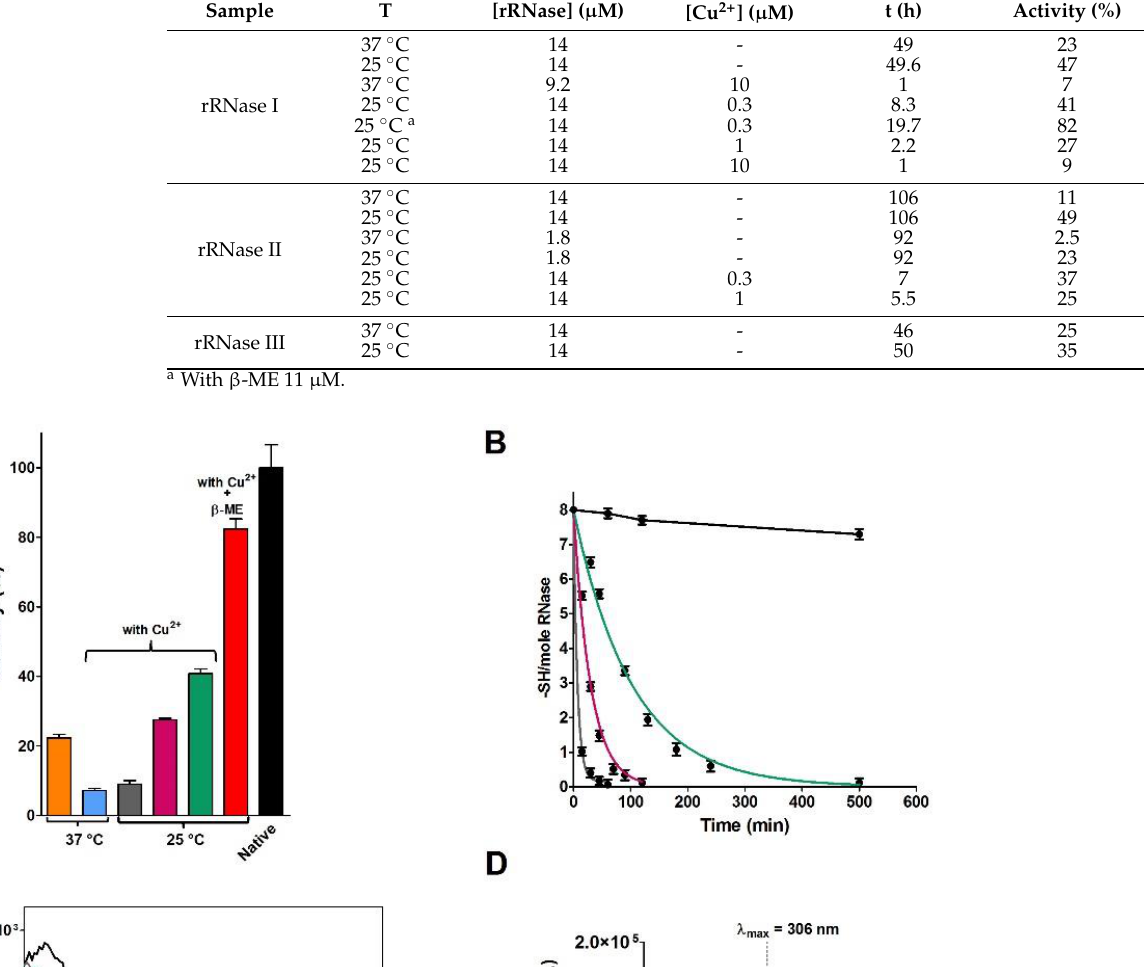
Table 1. Experiments of re-oxidation of rRNases.